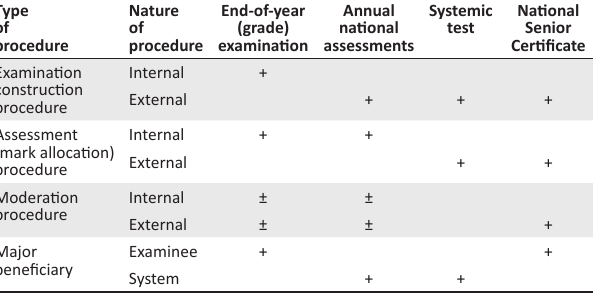
TABLE 1: Classification for different examinations operative in the South African schooling system. Type